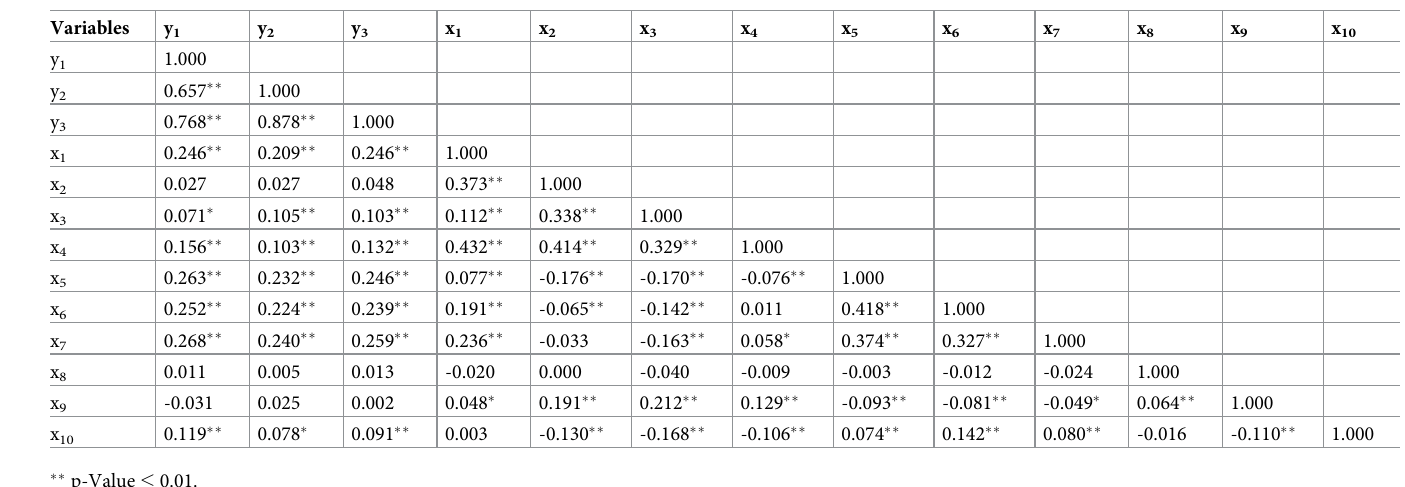
Table 4. Correlation matrix.